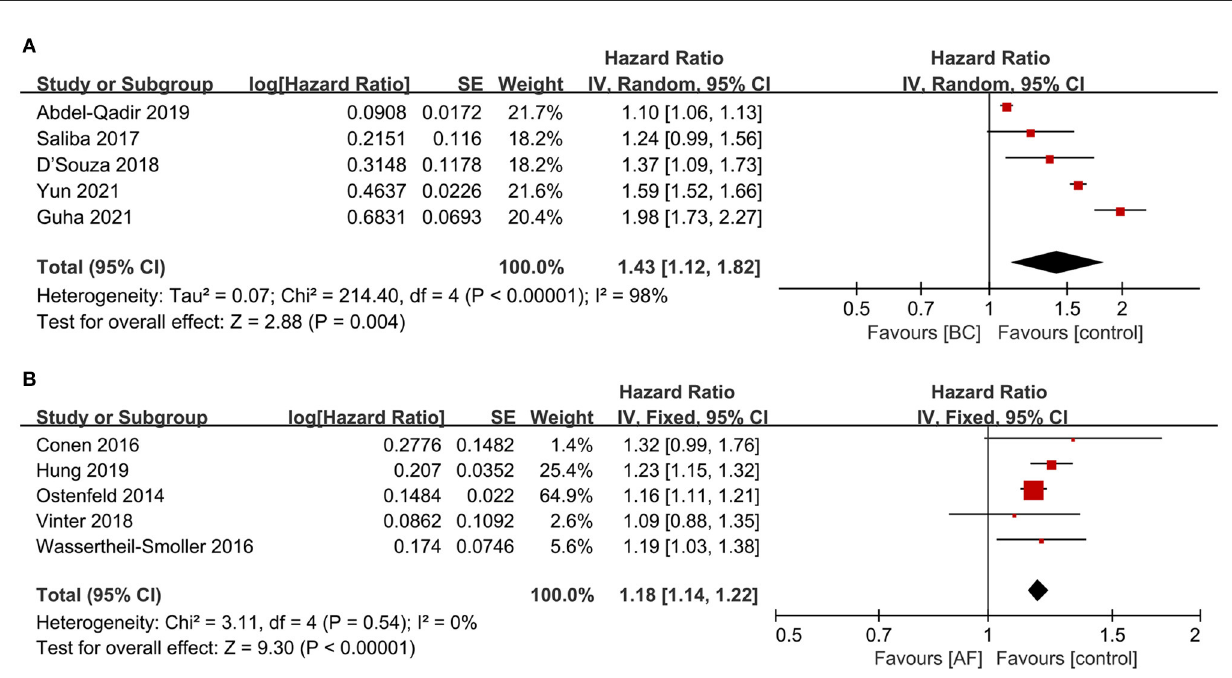
FIGURE4 Forest plot of bidirectional association between BC and AF [ (A) the risk of AF in patients with BC vs. (B) the risk of BC in patients with AF]. Inside the forest plot, the rhombus indicates the pooled estimate. Red square indicates study size. Black vertical lines indicate 95%CIs around the effect size estimate. AF, atrial fibrillation; BC, breast